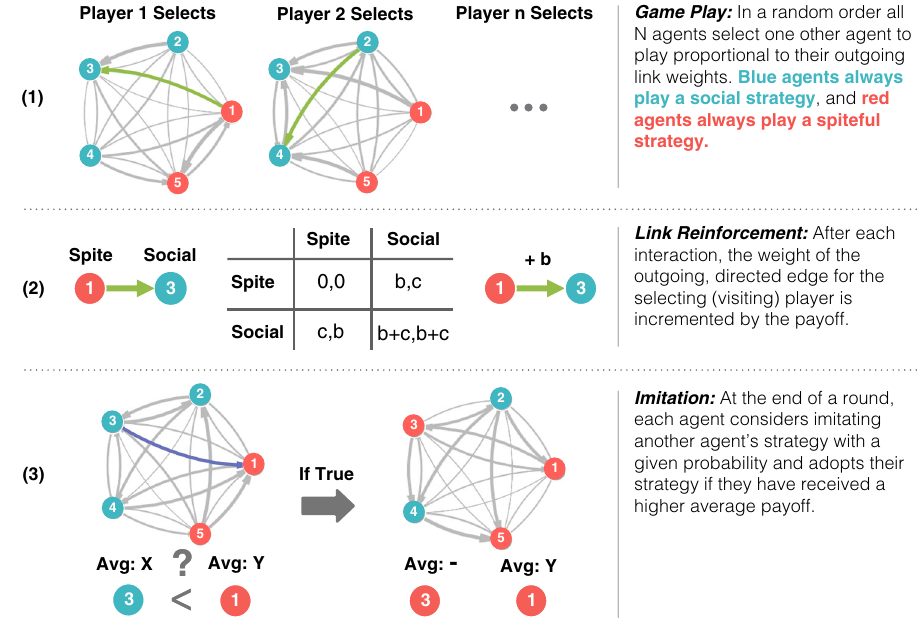
Fig. 1 Game play and updating mechanism. In each round, agents must ( 1 ) select an interaction partner, ( 2 ) update their network weight based on the payoff, and ( 3 ) consider imitation. We normalize the payoffs by setting b + c = 1 and examine variation in the ratio b / c